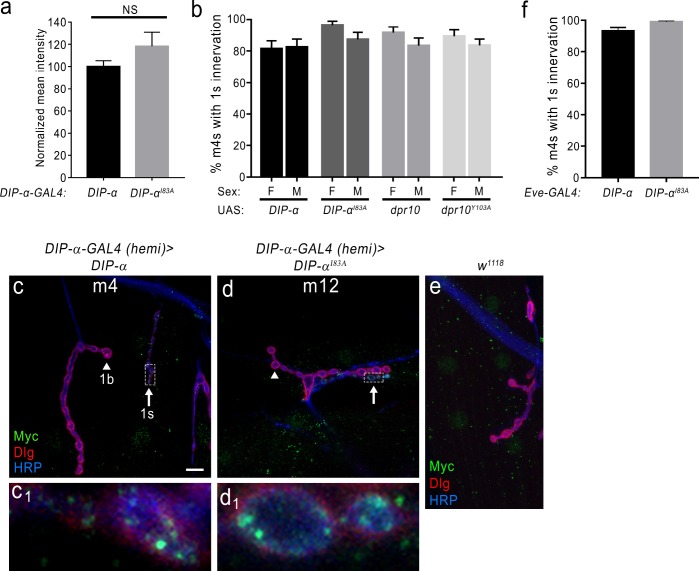
Loss of DIP-α homophilic interactions does not affect expression or localization of DIP-αI83A and innervation of m4 is not a sex-dependent variable.(a) Normalized mean intensity of overexpressed UAS-DIP-α and UAS-DIP-αI83A in motor neuron terminals that normally express DIP-α (see Materials and methods). (b) Quantification of 1 s innervation of m4 in male vs female larvae in each of the control transgene genotypes (UAS line crossed to a w1118). Note that there is no statistical difference between males and females. (c) Rescue of the DIP-α loss-of-function phenotype by introducing a UAS-DIP-α (fused to Myc) in cells that normally express DIP-α. In c1), DIP-α (green) properly localizes to the 1 s NMJ at m4. (d) Expression of UAS-DIP-αI83A fails to rescue the DIP-α loss-of-function phenotype at m4 but DIP-αI83A localizes normally at other 1 s synapses such as those on m12 (d1). (e) Labeling with anti-Myc antibody in a control w1118 preparation reveals background cross-reactivity of this antibody. (f) Quantification of 1 s innervation of m4 in flies either expressing UAS-DIP-α or UAS-DIP-αI83A under the control of EveRN2-GAL4 (a GAL4 driver that expresses in the MNISN-1s neurons). Error bars represent S.E.M. n: See Figure 7—source data 1. Also see Figure 7.